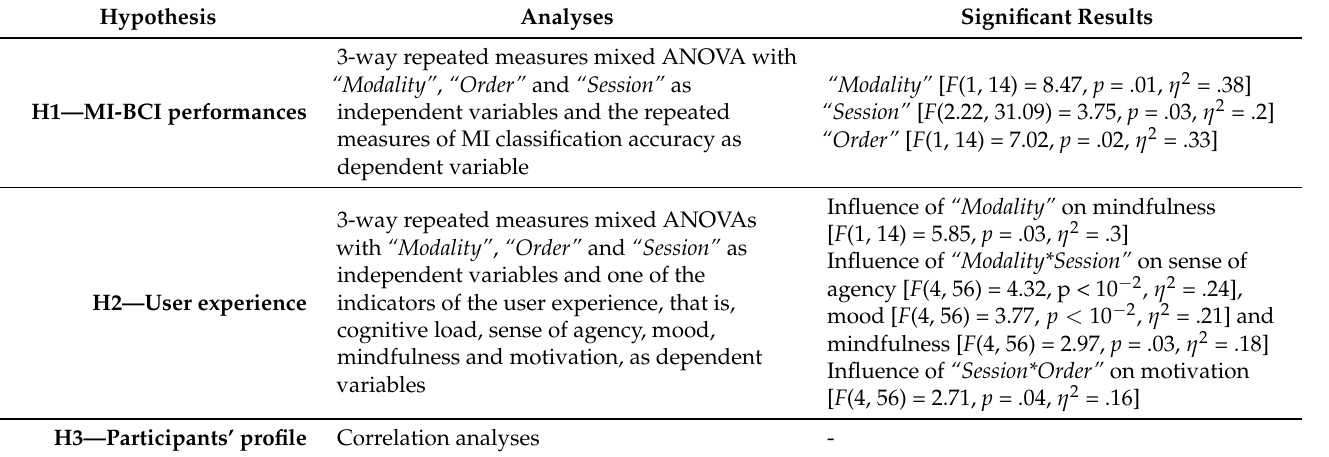
Table 1. Summary of the significant results per